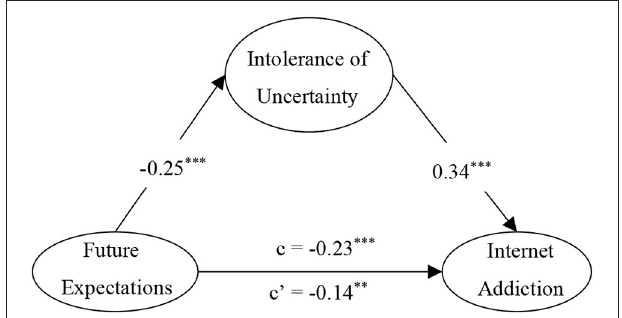
FIGURE 2 | The mediating effect of intolerance of uncertainty in the association between future expectations and internet addiction. ** p < 0.01, *** p < 0.001.